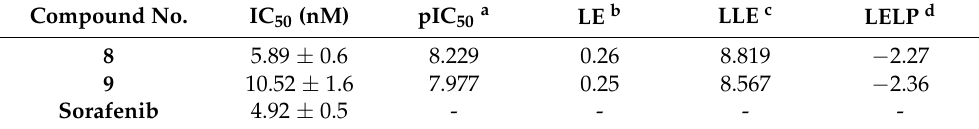
Table 3. In vitro VEGFR-2 inhibitory activities of 8 and 9 and their ligand efficiency metrics. Compound No.